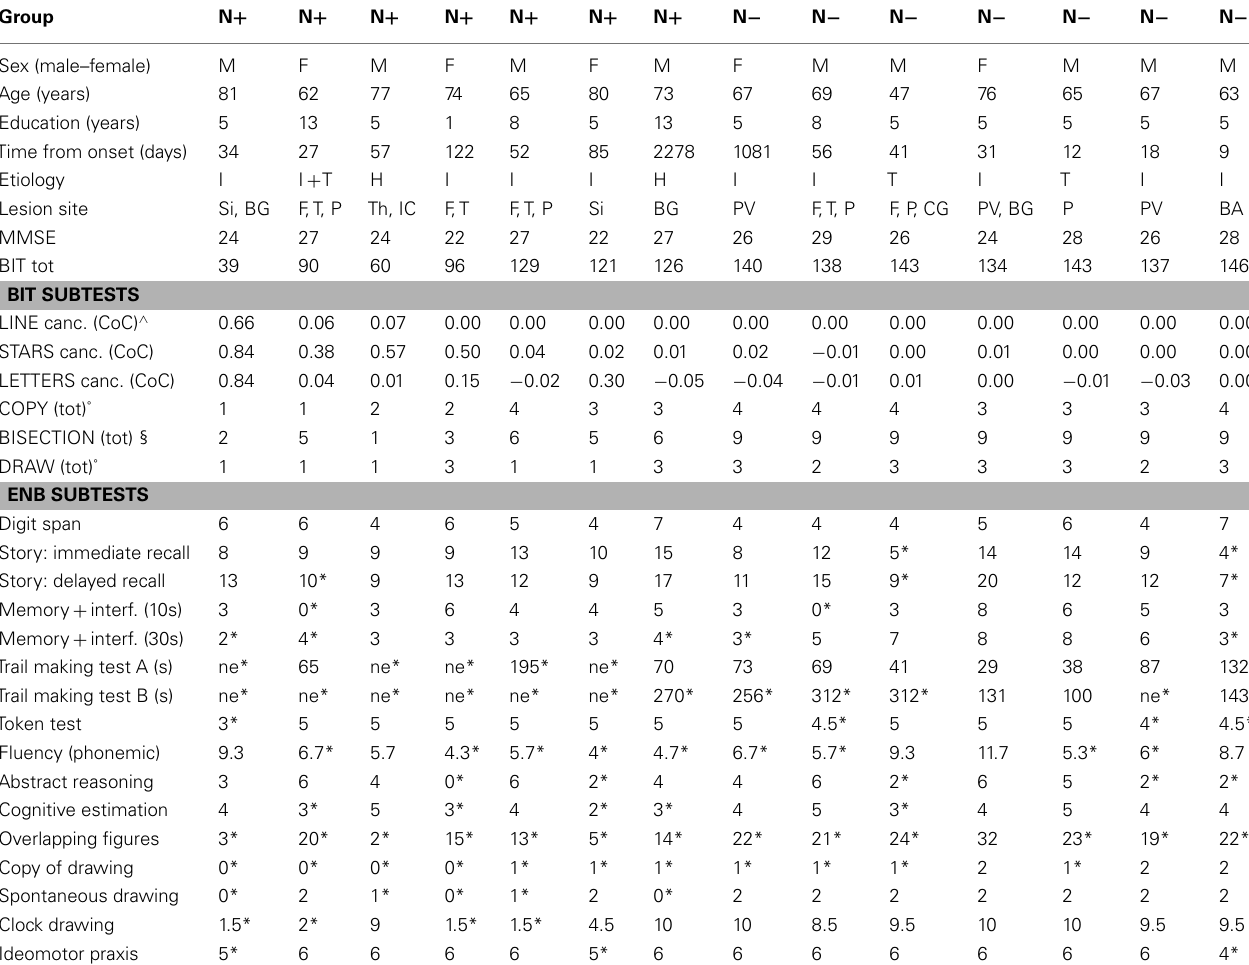
Table 1 | Demographic data and test scores of right brain damaged patients with neglect (N + ) and without neglect (N − ). Group N